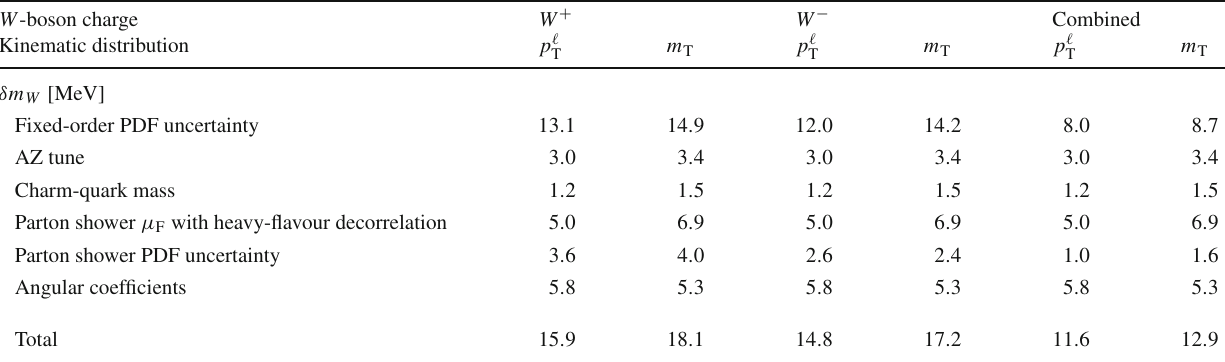
the total experimental uncertainties, and the bands show the uncertain- ties assigned to the DYNNLO predictions rate W + and W − final states corresponds to the quadrature sum of the CT10nnlo uncertainty variations; the charge-combined uncertainty also contains a 3 . 8MeV contribution from comparing CT10nnlo to CT14 and